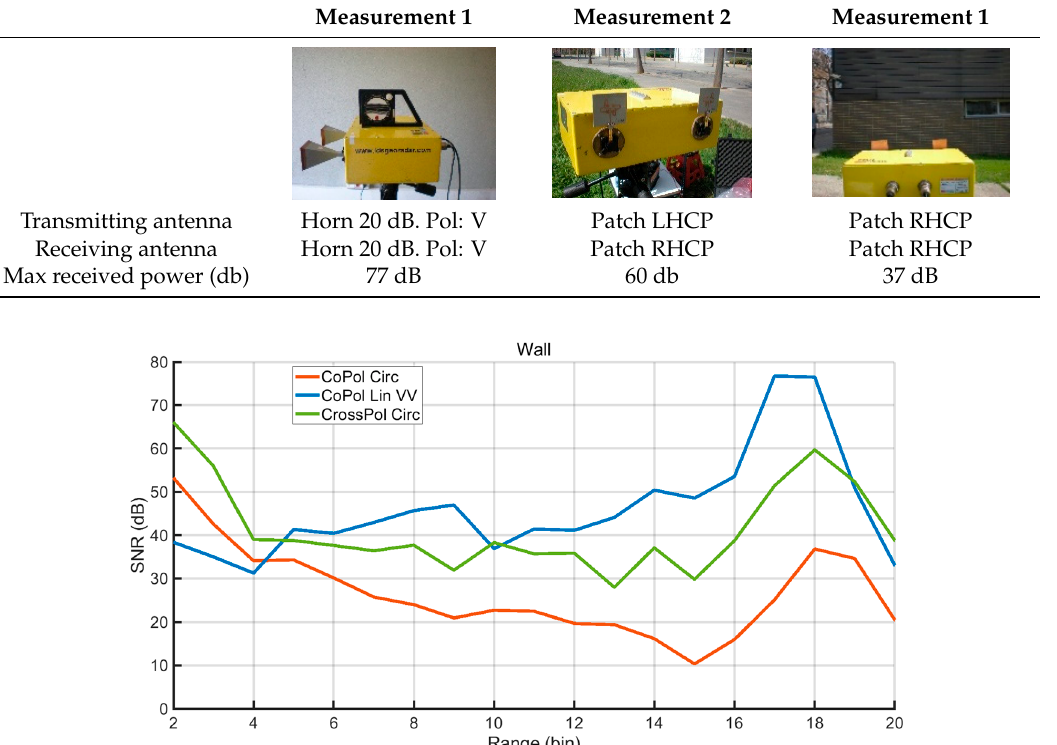
Table 3. Results of the measurements carried out to estimate the difference among VV, cross-polar, and co-polar CP wall response.